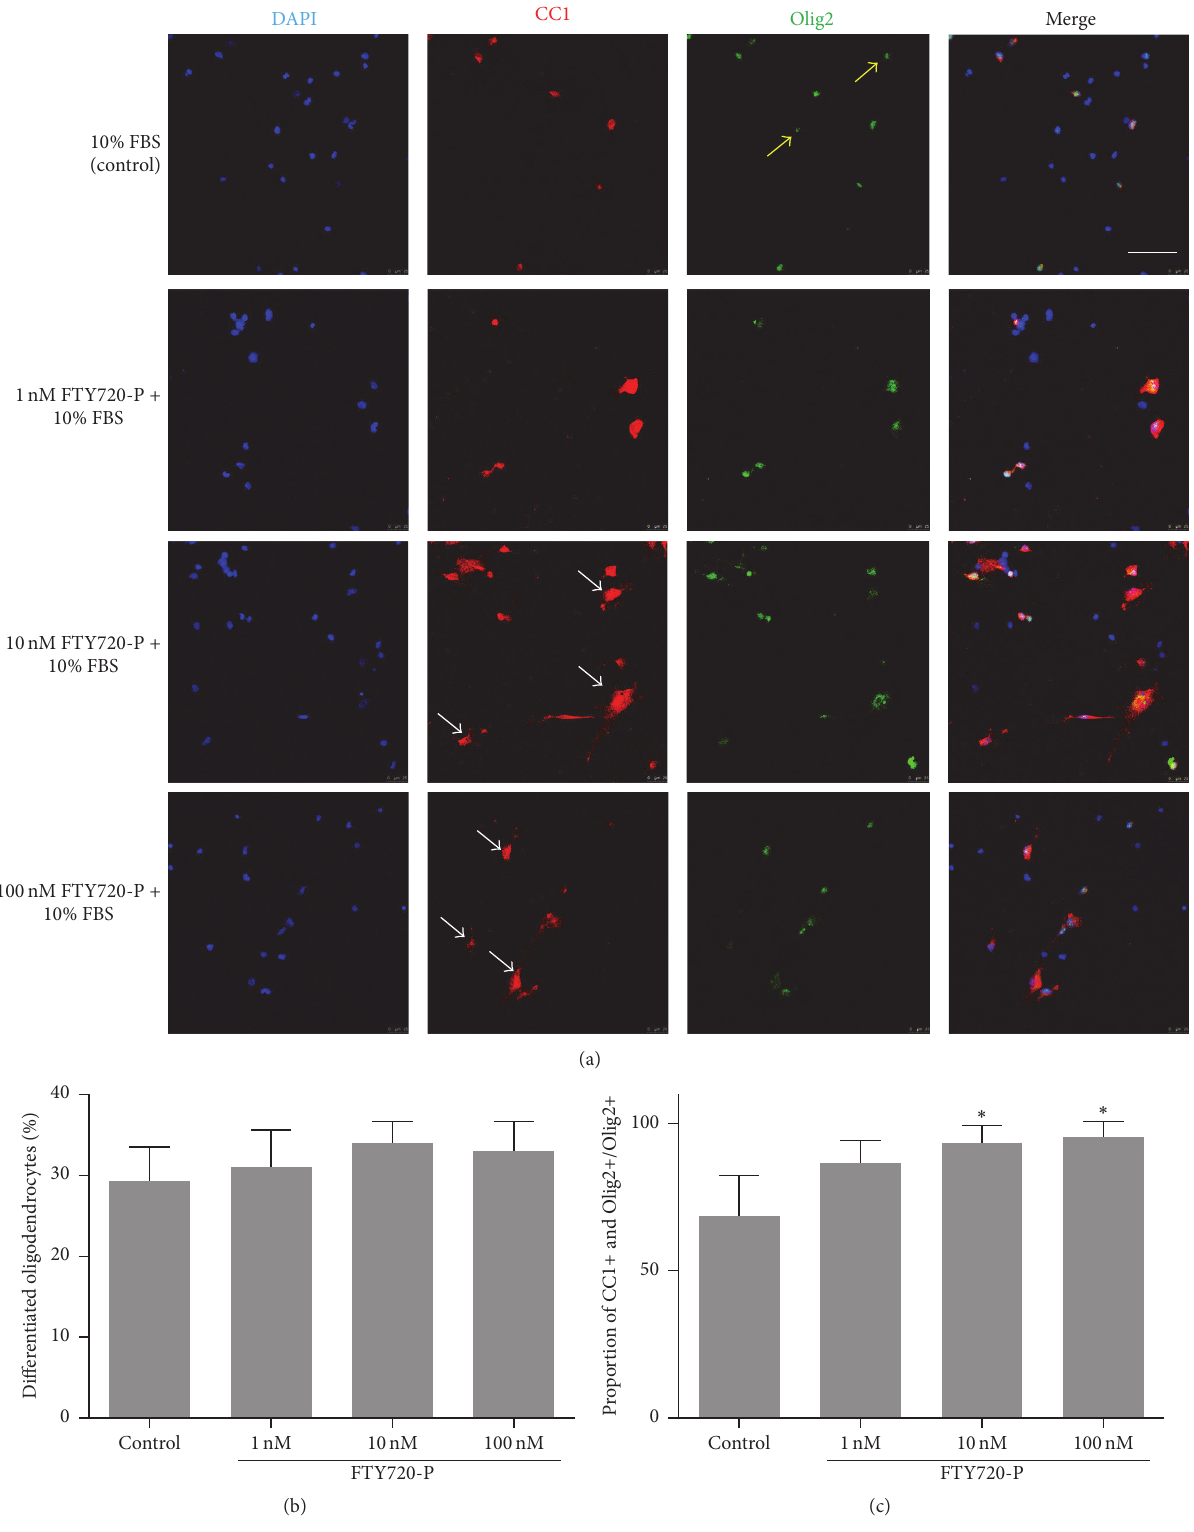
Figure 4: Differentiation of NSCs into oligodendrocytes in the presence of FTY720. (a) Representative images of differentiated oligoden- drocytes in different groups. Matured oligodendrocytes are both Olig2 (Green) and CC1 (Red) positive. Parts of the Olig2+ cells in the control group did not express CC1 (yellow arrows) while more morphological matured (white arrows) oligodendrocytes were seen in higher FTY720 concentration groups. Bar = 50 𝜇 m. ((b)-(c)) Quantification of the proportion of differentiated oligodendrocytes. 𝑛 = 3 in each group. ∗ 𝑃 < 0.05 , compared with control group, by ANOVA, followed by Dunnett’s multiple comparison